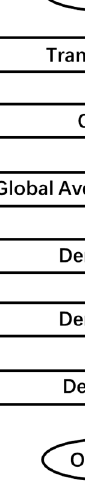
Figure 3. DDosTC flow chart.